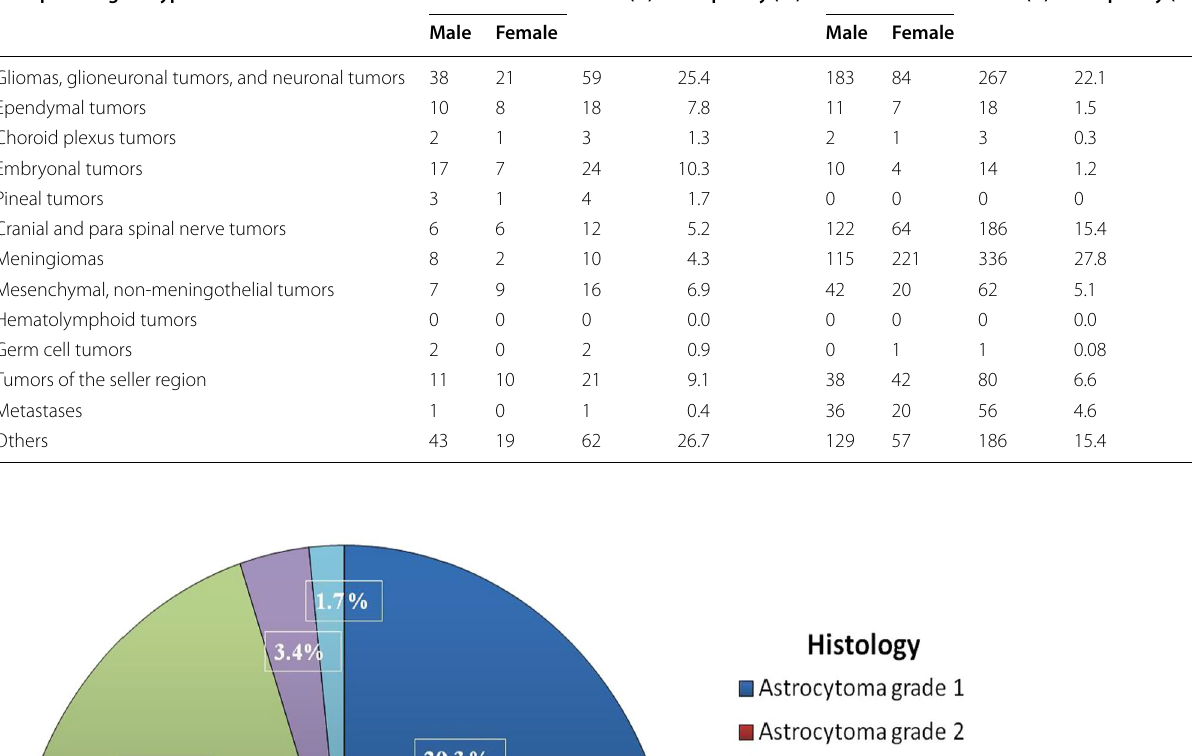
Table 4 Histopathological wise distribution of primary brain and other CNS tumors in pediatric and adult patients Histopathological type